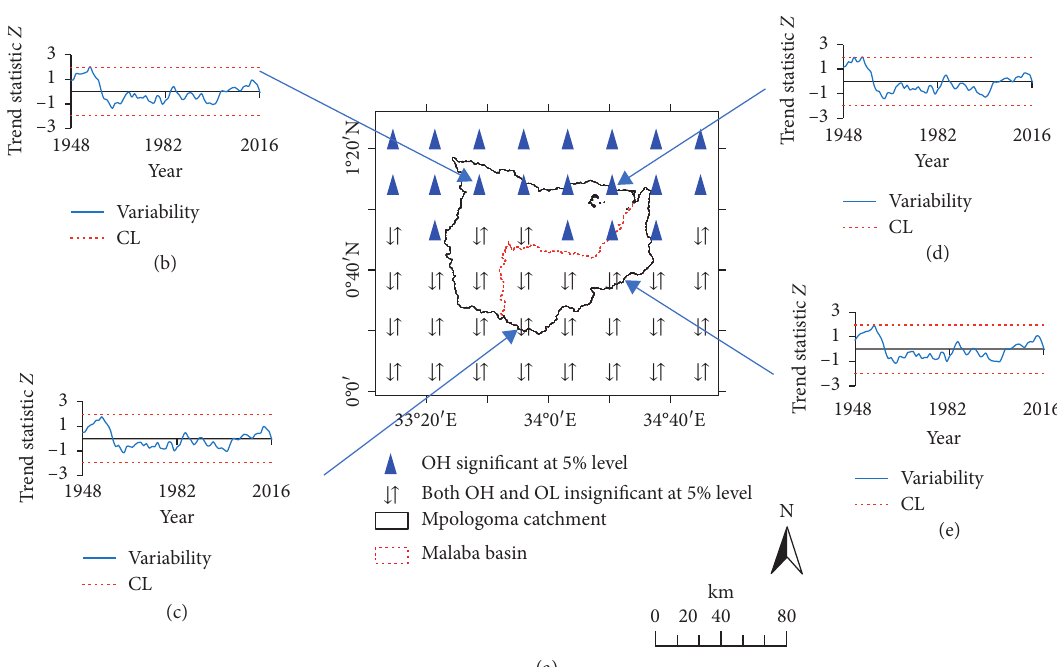
Figure 6: Spatial differences in the significance of rainfall variability (a) and temporal variability in MAM rainfall (b–e) at different locations of the study area.